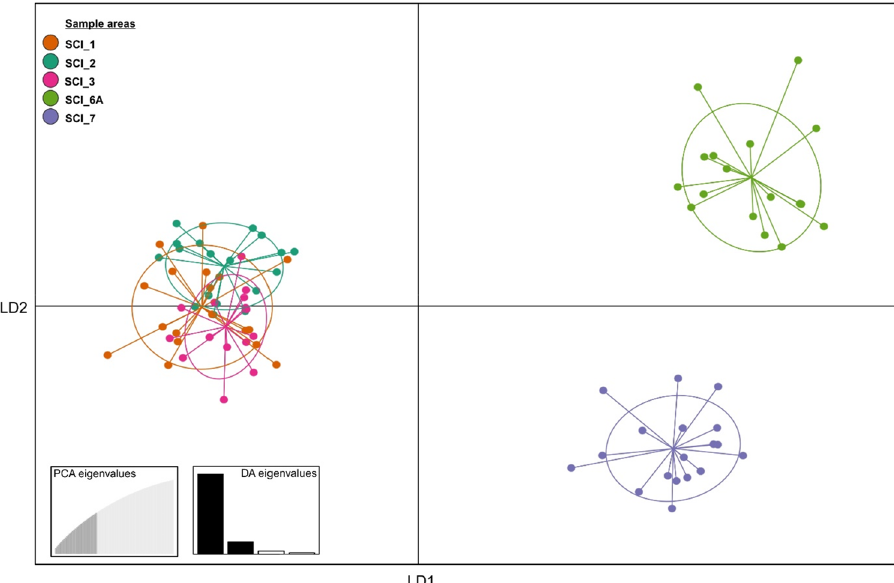
Figure 2. Scatterplot of the DAPC data showing the clustering of scampi individuals from their respective scampi fishery management areas (SCIs). SCIs are indicated by different colours, while dots represent individuals.